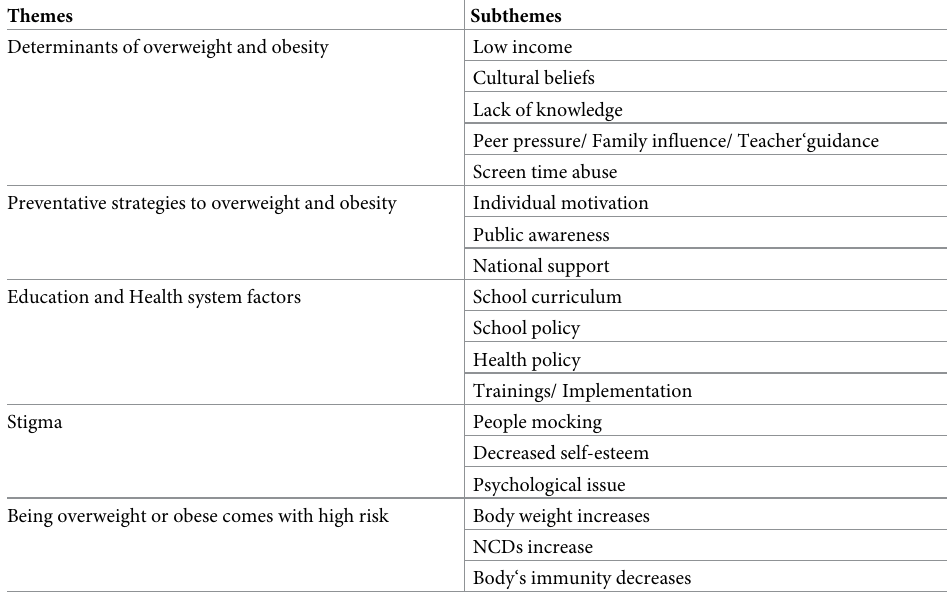
Table 2. Themes from student‘s in-depth